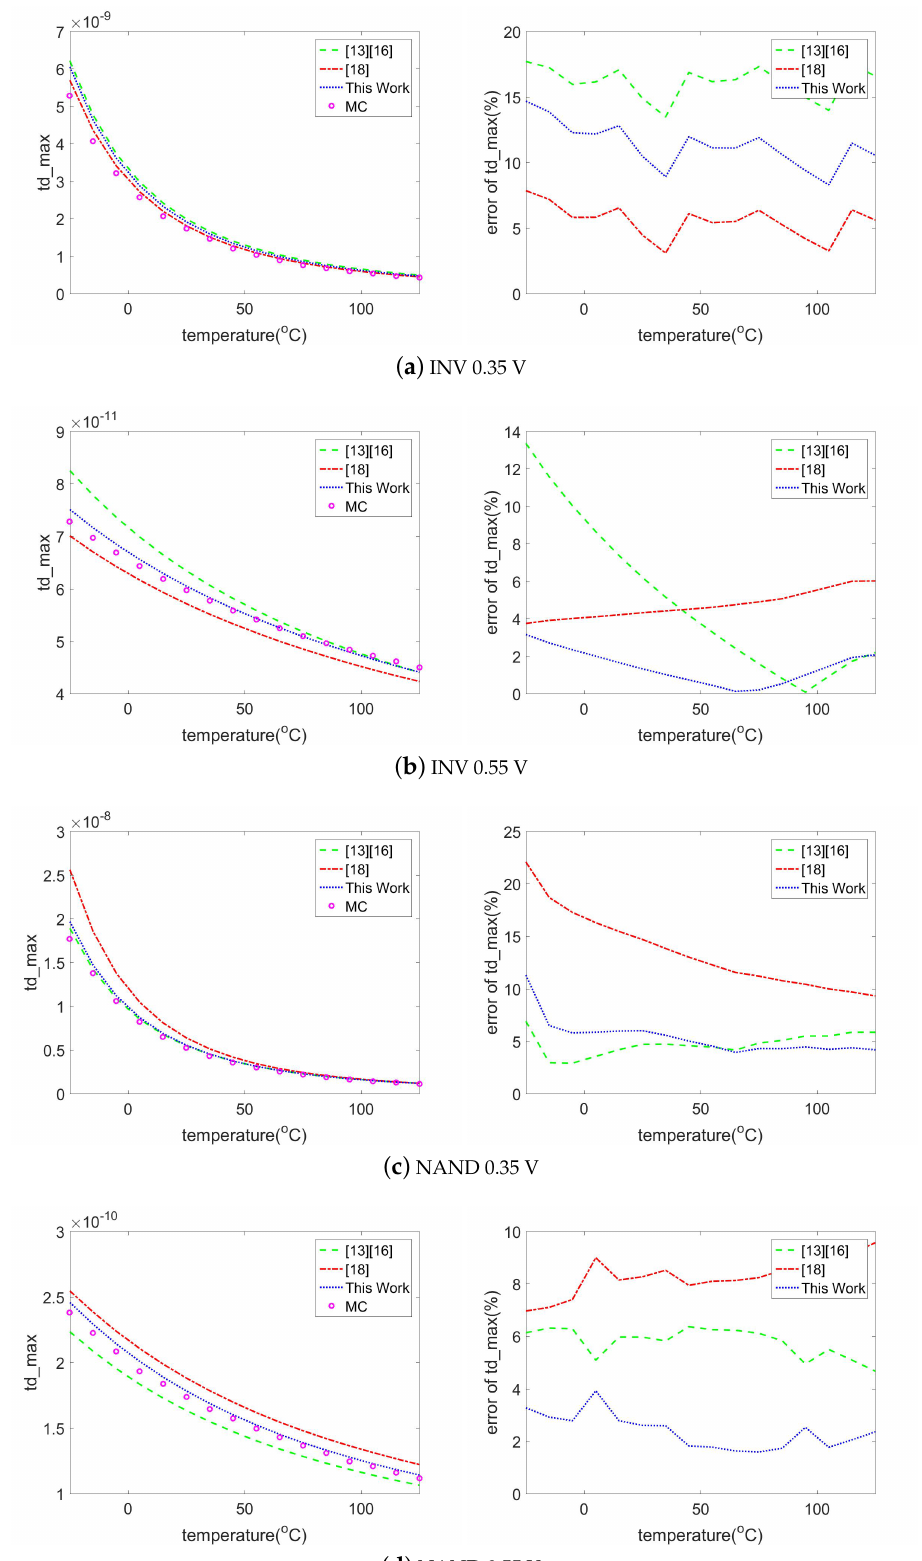
Figure 5. Comparison of maximum delay with different temperature under different gates and voltages: ( a ) INV 0.35 V; ( b ) INV 0.55 V; ( c ) NAND 0.35 V; ( d ) NAND 0.55